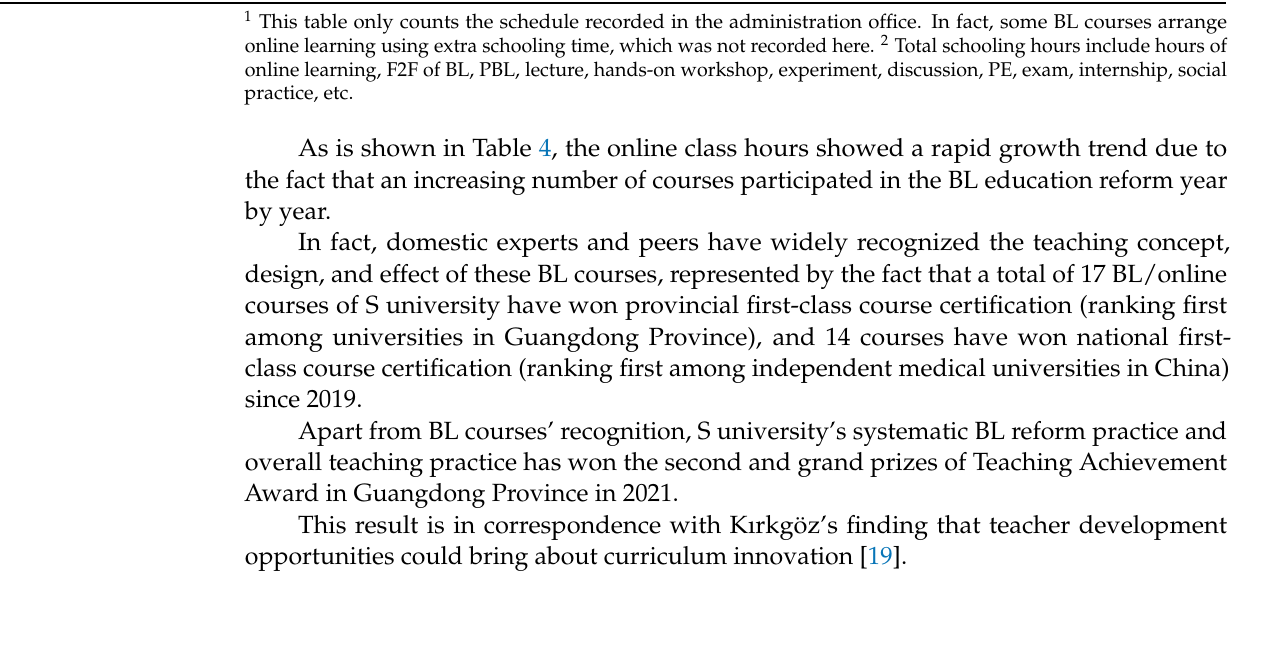
Table 4. Teaching hours of BL course in S university.